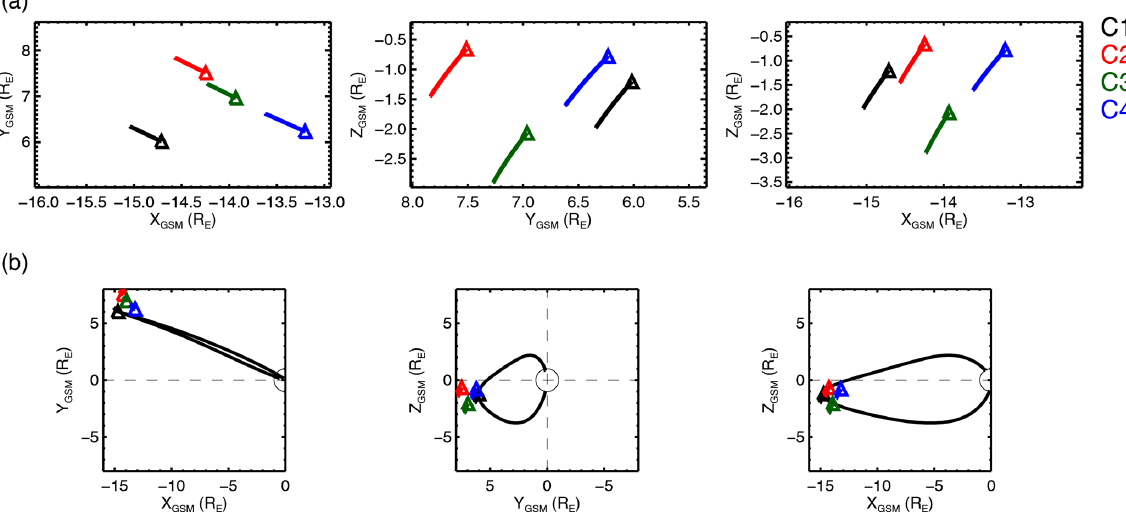
Figure 1. (a) The locations of the Cluster spacecraft in the X – Y , Y – Z and X – Z GSM planes, from left to right, respectively, at 00:00UT on 12 October 2006, marked by the triangles. The trajectories from 00:00 to 00:55UT are marked by the solid lines. The spacecraft are colour-coded according to the key on the right. (b) Same as in (a) with a zoomed-out view. The Earth is shown by the solid circle. A TA15 model magnetic field line passing through the location of C1 is shown as the solid black